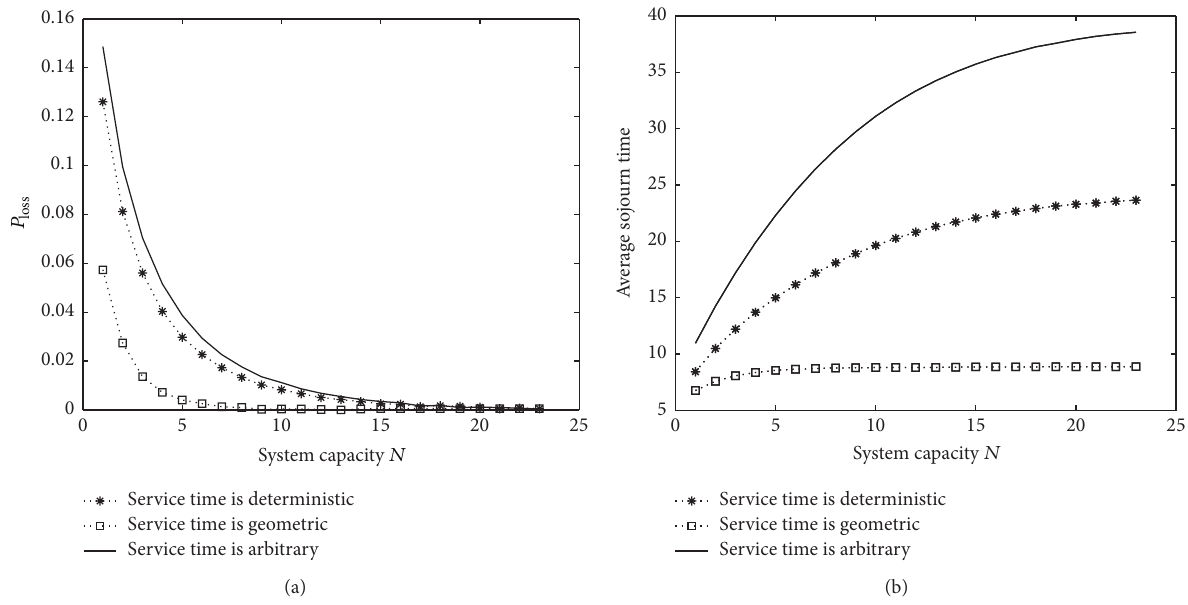
Figure 3: (a) Effect of 𝑁 on blocking probability under different service time distributions. (b) Effect of 𝑁 on average sojourn time under different service time distributions.